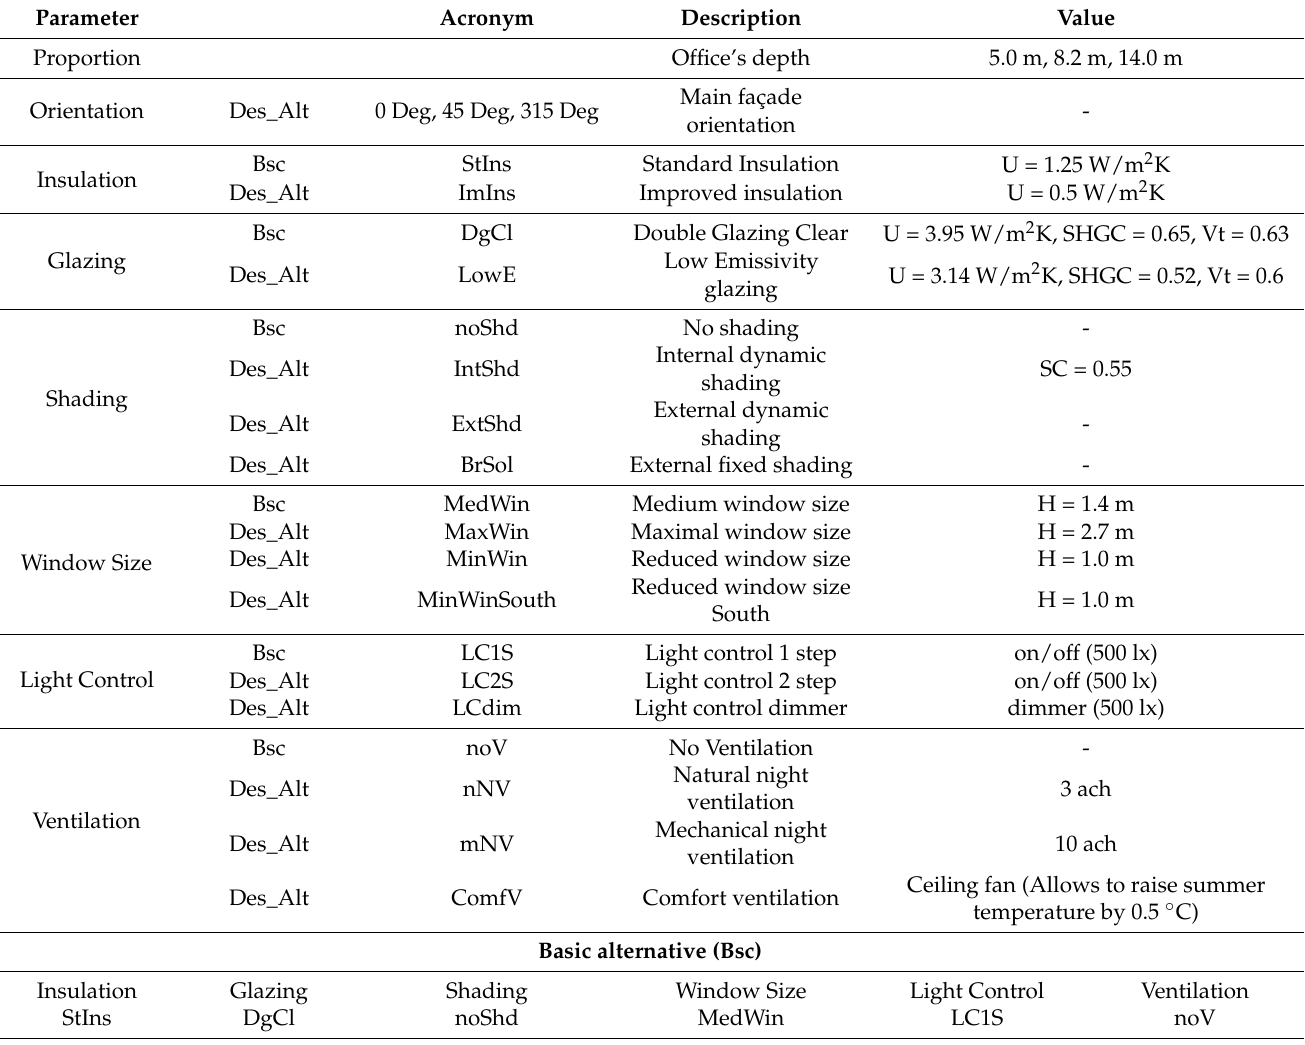
Table 3. Office building case with design